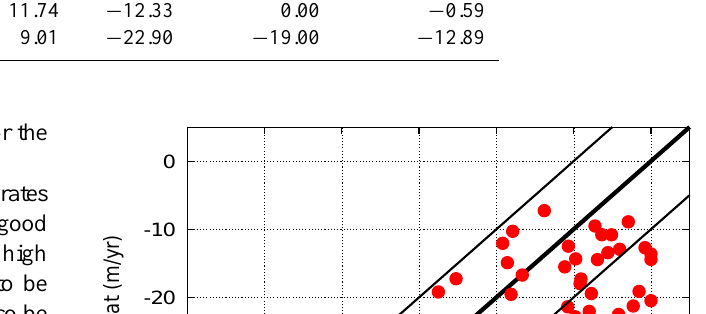
Table 4. Computed and observed retreats for the predicted set. RMS error is 3.82myr − 1 . dL Glacier Length Slope dL Retreat (obs) Retreat (comp) dt dyn dt thermo (km) (myr − 1 ) (myr − 1 ) (myr − 1 ) (myr − 1 ) AX010 1.6 0.180 0.27 − 9.25 ZEMU 28.0 0.135 11.74 − 12.33 0.00 GANGOTRI 30.0 0.076